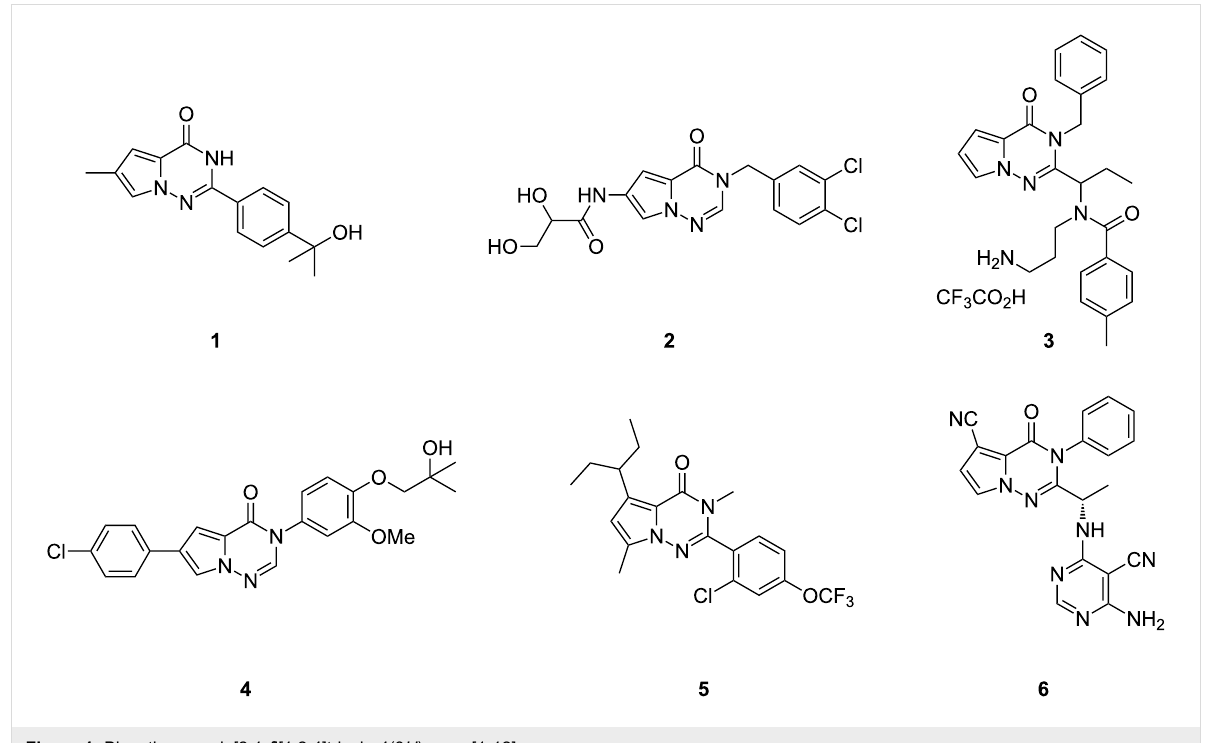
Figure 1: Bioactive pyrrolo[2,1- f ][1,2,4]triazin-4(3 H )-ones [1-12].